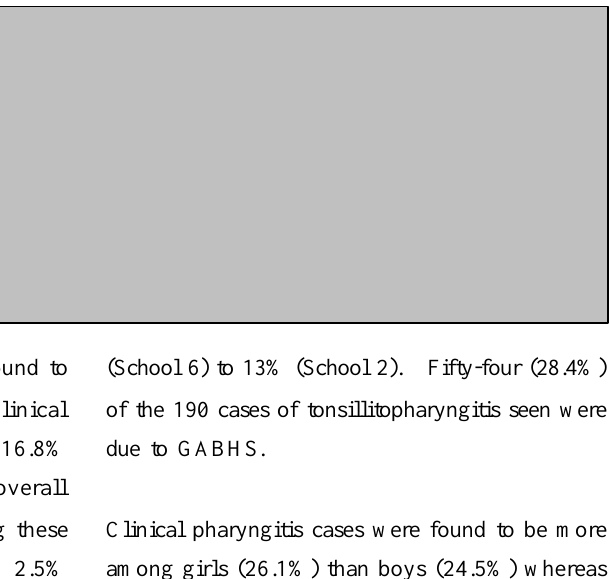
Table II: Prevalence of Clinical and GABHS Pharyngitis in 6 schools.